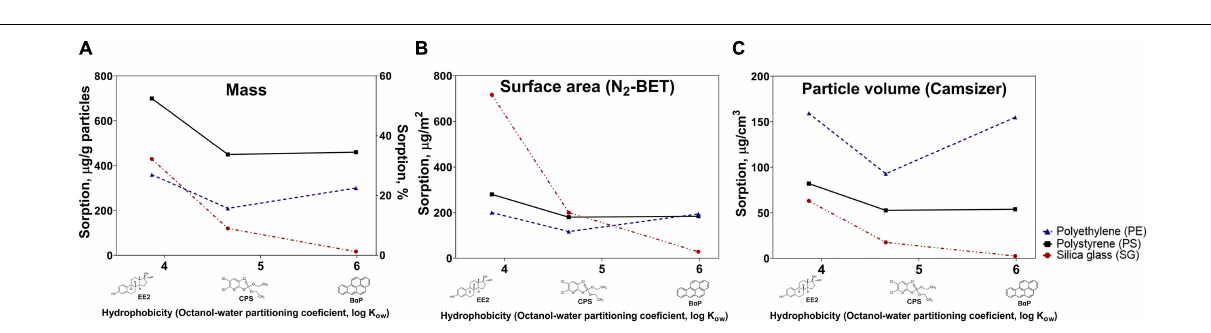
FIGURE 2 | Sorption of model compounds (EE2, CPS, and B α P) on experimental microparticles (PE, PE, and SG) measured per mass of particles ( A ; µ g/g and %) and sorption estimates normalized for specific N 2 -BET surface area ( B ; µ g/m 2 ) and particle volume ( C ; µ g/cm 3